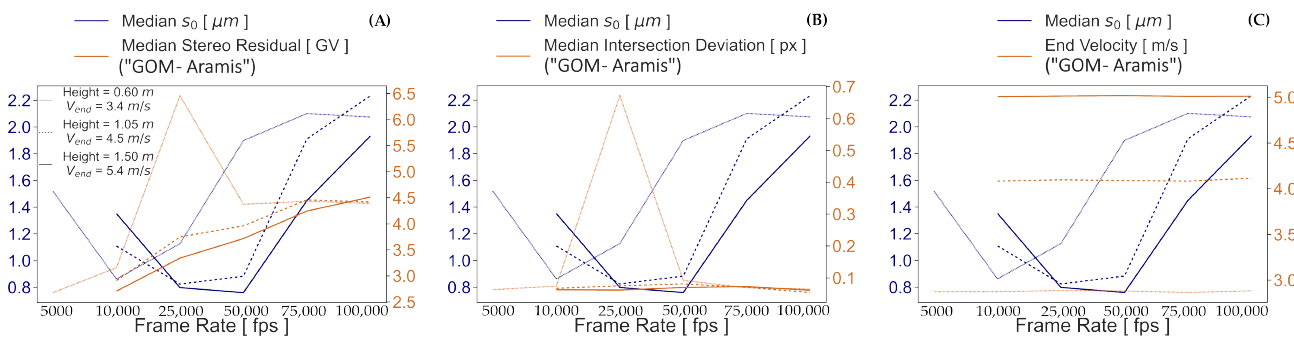
Figure 16. SNR P of SP 02, considering the 5 recorded exposure times at the 03 Height. px